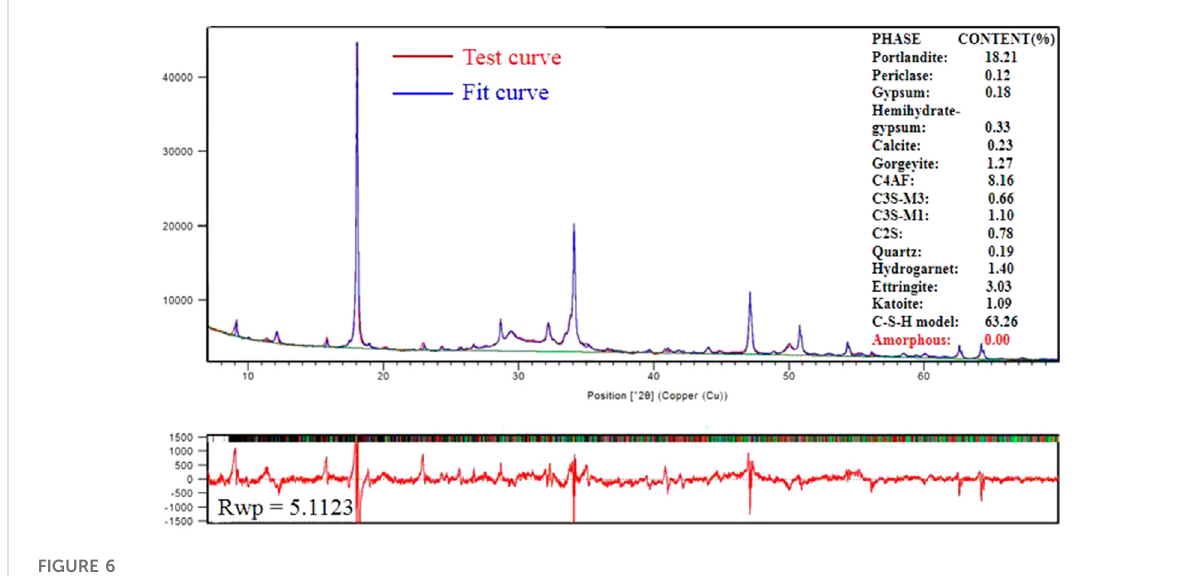
FIGURE 6 Establishing the calcium – silicate – hydrates model through the partial or no known crystal structure method.